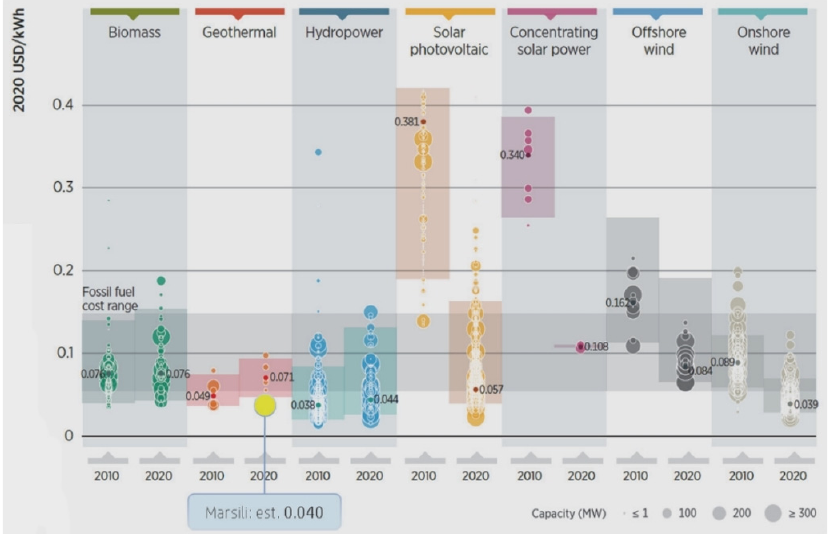
Figure 6. Global LCOE (Levelized Cost of Energy) of newly commissioned utility-scale renewable power generation technologies, 2010 and 2020 (redrawn from [84]). Marsili LCOE is among the lowest values in comparison with other renewable energy sources, the estimation is 0.04 USDkWh − 1 (the circle filled in yellow).